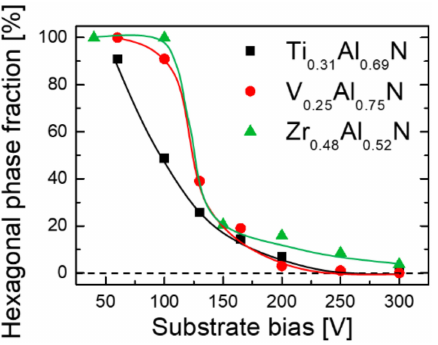
Figure 2. Relative w-AlN content extracted from the areas of wurtzite 1010 and rock salt structure 002 diffraction peaks integrated over all ψ angles and normalized to random powder XRD patterns plotted as a function of the synchronous bias voltage for Zr 0.48 Al 0.52 N, V 0.26 Al 0.74 N, and Ti 0.31 Al 0.69 N